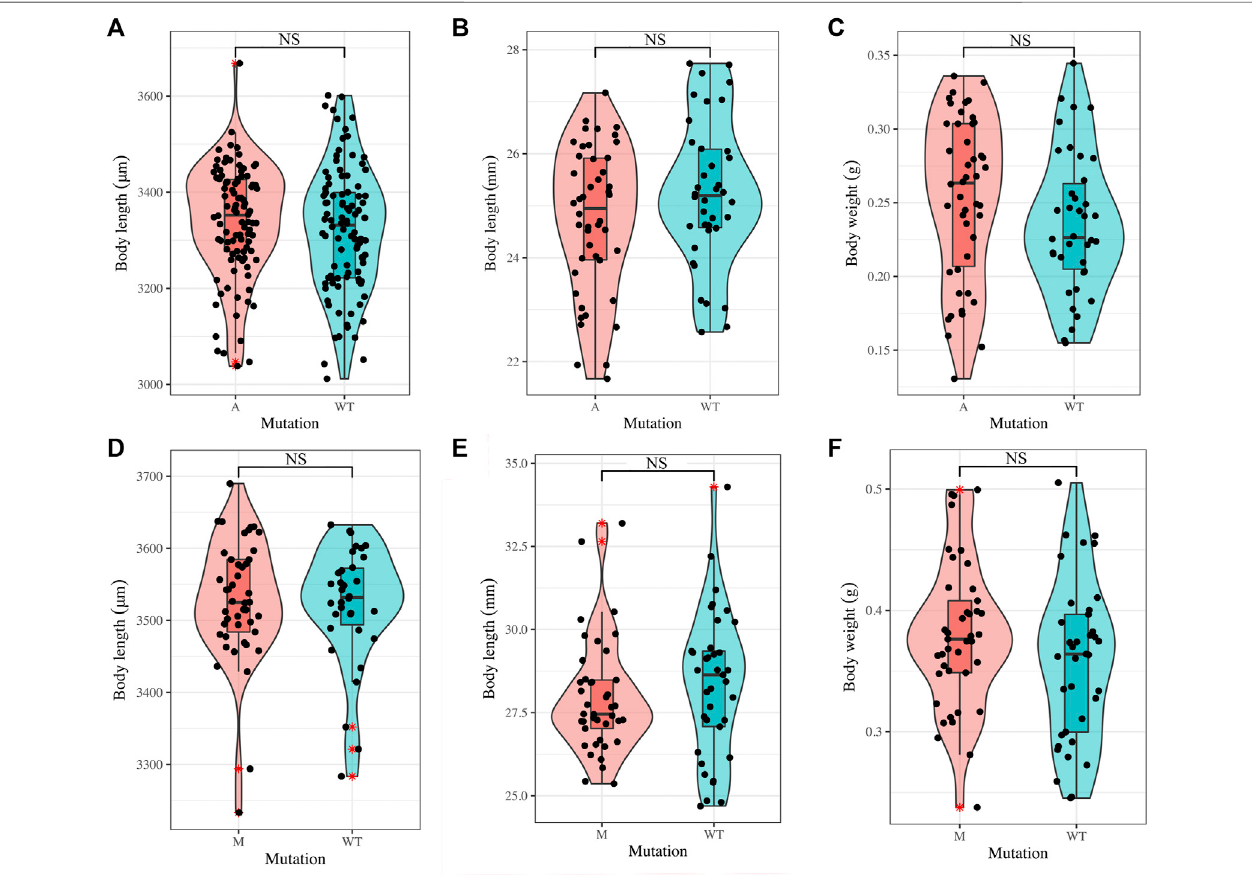
FIGURE4| Growthofmutantsandwild-typezebra fi sh. (A) Comparisononthelarvaebodylengthofwild-typezebra fi sh(n=100)andAmutants(n=100)at72hpf. (B, C) Comparison onthe adult bodylength(B)and bodyweight (C) ofwild-type zebra fi sh (n=38) and Amutants (n=46) at 90dph. (D) Comparison on thelarvae body length of wild-type zebra fi sh (n = 34) and M mutants (n = 45) at 72 hpf. (E,F) Comparison on the adult body length (E) and body weight (F) of wild-type zebra fi sh (n = 37) and M mutants (n = 41) at 90 dph. Student ’ s t -test was used to test the difference. NS: not signi fi cant.